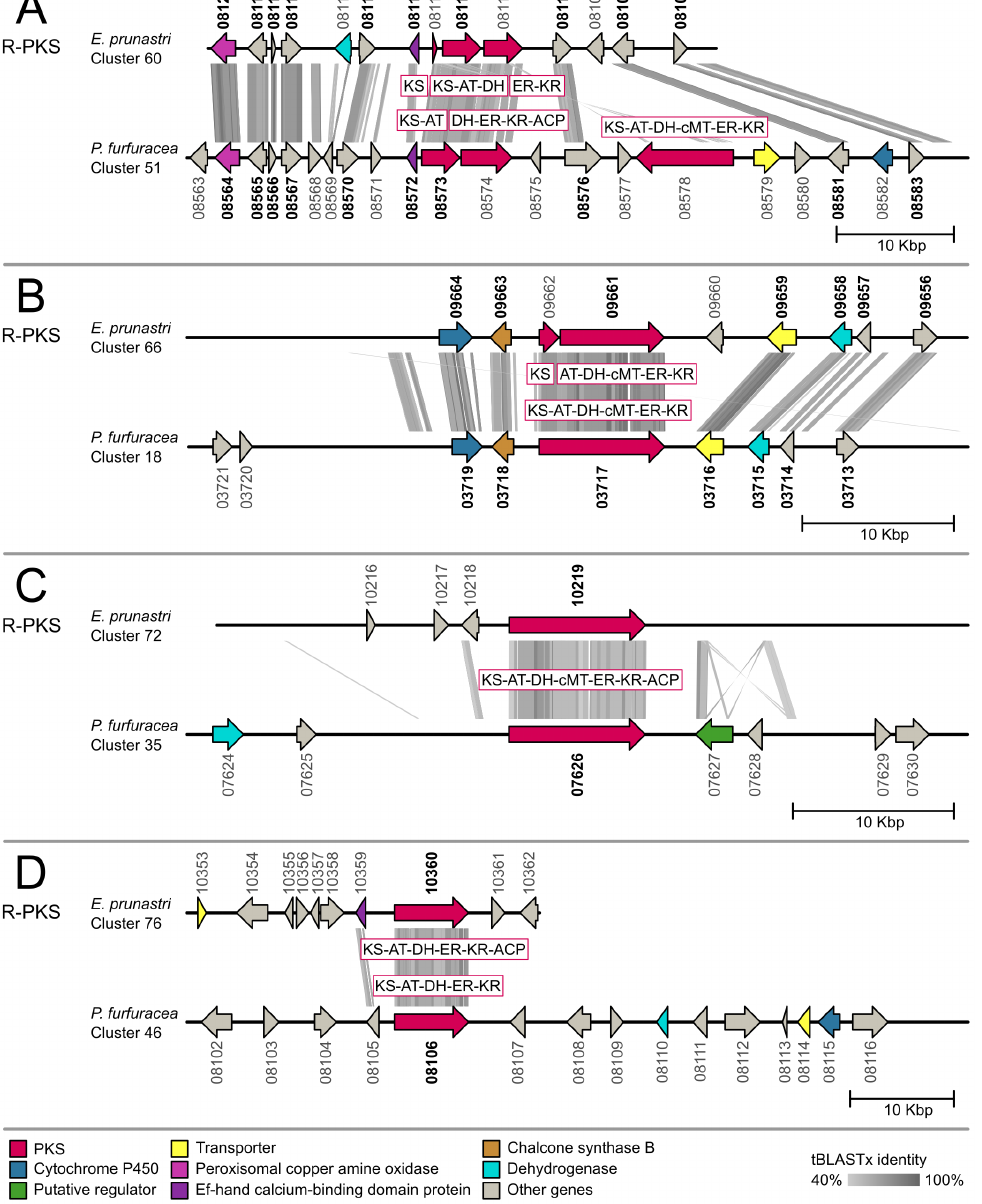
Figure 4. Synteny plots of biosynthetic gene clusters with an ortholog reducing polyketide synthase (R-PKS) core gene in Evernia prunastri and Pseudevernia furfuracea . Orthologous genes identified with the reciprocal best hit (RBH) approach are highlighted in bold. ACP = Acyl carrier protein; AT = Acyltransferase; cMT = C-Methyltransferase; DH = Dehydratase; ER = Enoylreductase; KR = Ketoreductase; KS = Ketosynthase; TE =